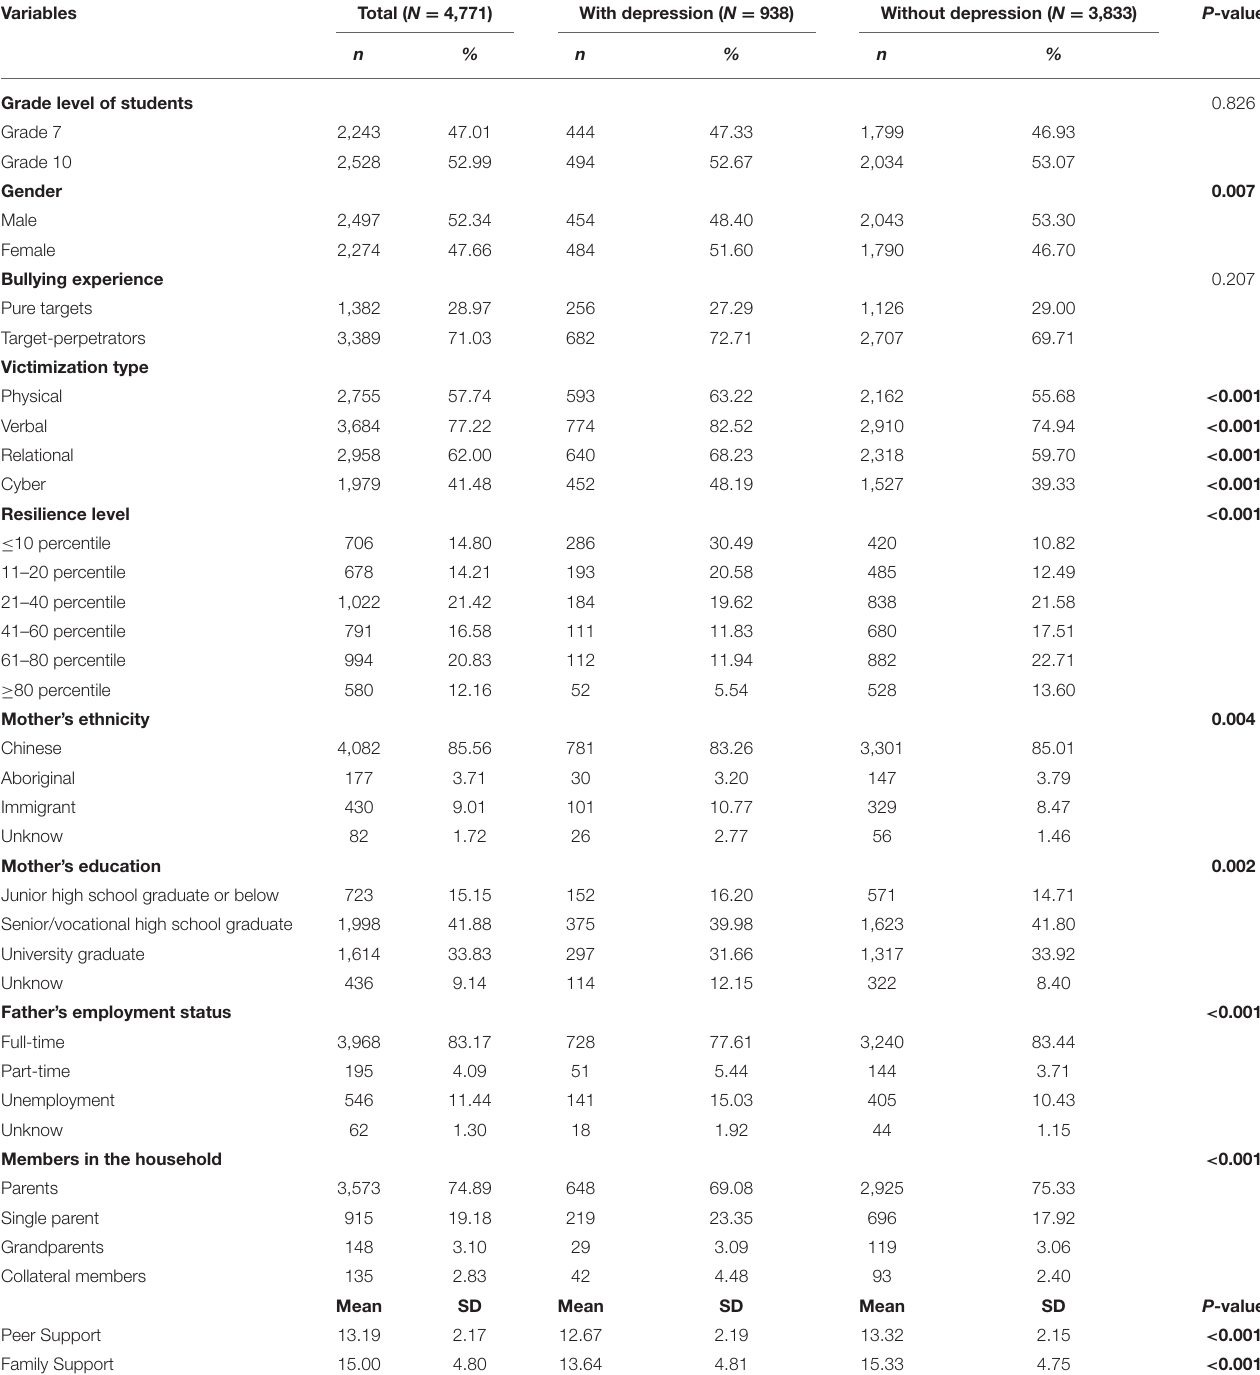
TABLE 1 | Baseline characteristics among victims of bullying with and without depression.